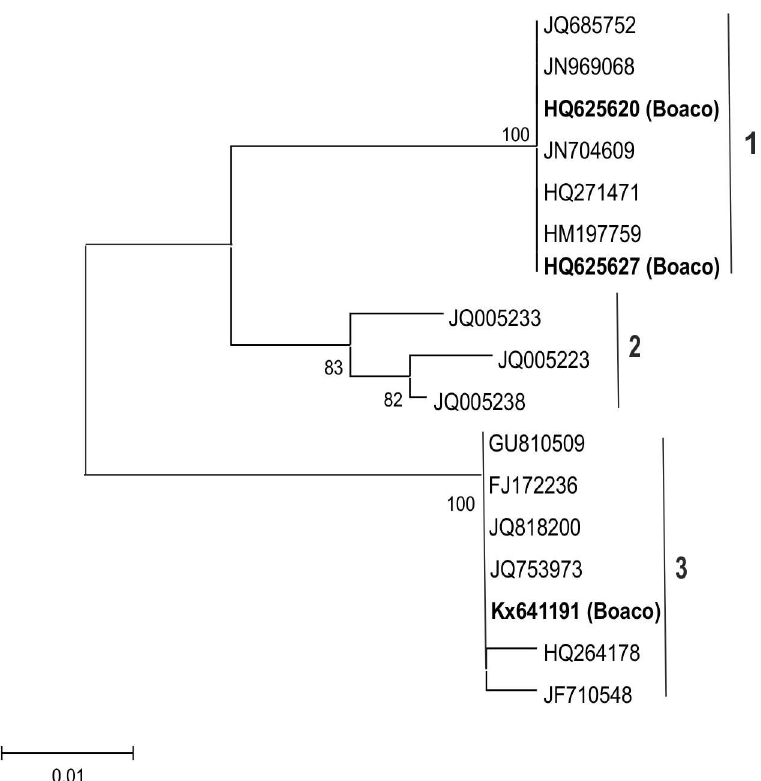
Fig 6. Phylogenetic grouping of the fungal isolates in phenogroup V. Partial ITS1 and the whole5.8S and ITS2 sequences(~450 nt) of the fungi isolatedfrom beansgrown in Boaco (bold letters) were includedin the phylogenetic analysiswith sequencesof Colletotrichum capsici (clade 1), C . gloeosporioides (clade 3), C . parsonsiae (JQ005233), C . petchii (JQ005223), and C . constrictum (JQ00538)(clade 2) obtainedfrom sequencedatabases (S1 Table). Numbers at branchesrepresent bootstrapvalues of 1000replicates. Only bootstrapvalues of (cid:21) 70% are shown. Scale indicatesKimura units in nucleotide substitutionsper